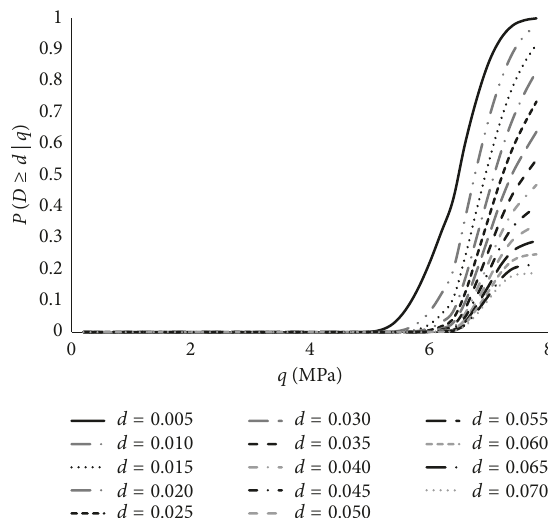
Figure 5: Fragility curves for different